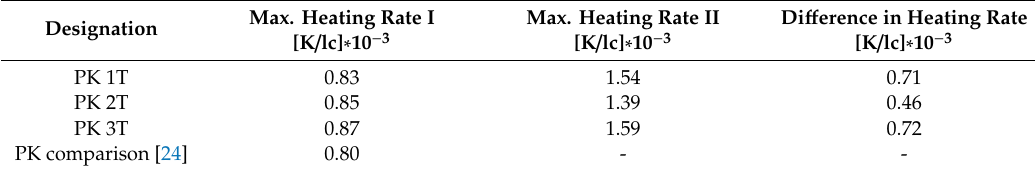
Table 4. Maximum heating rate at first and second cyclic